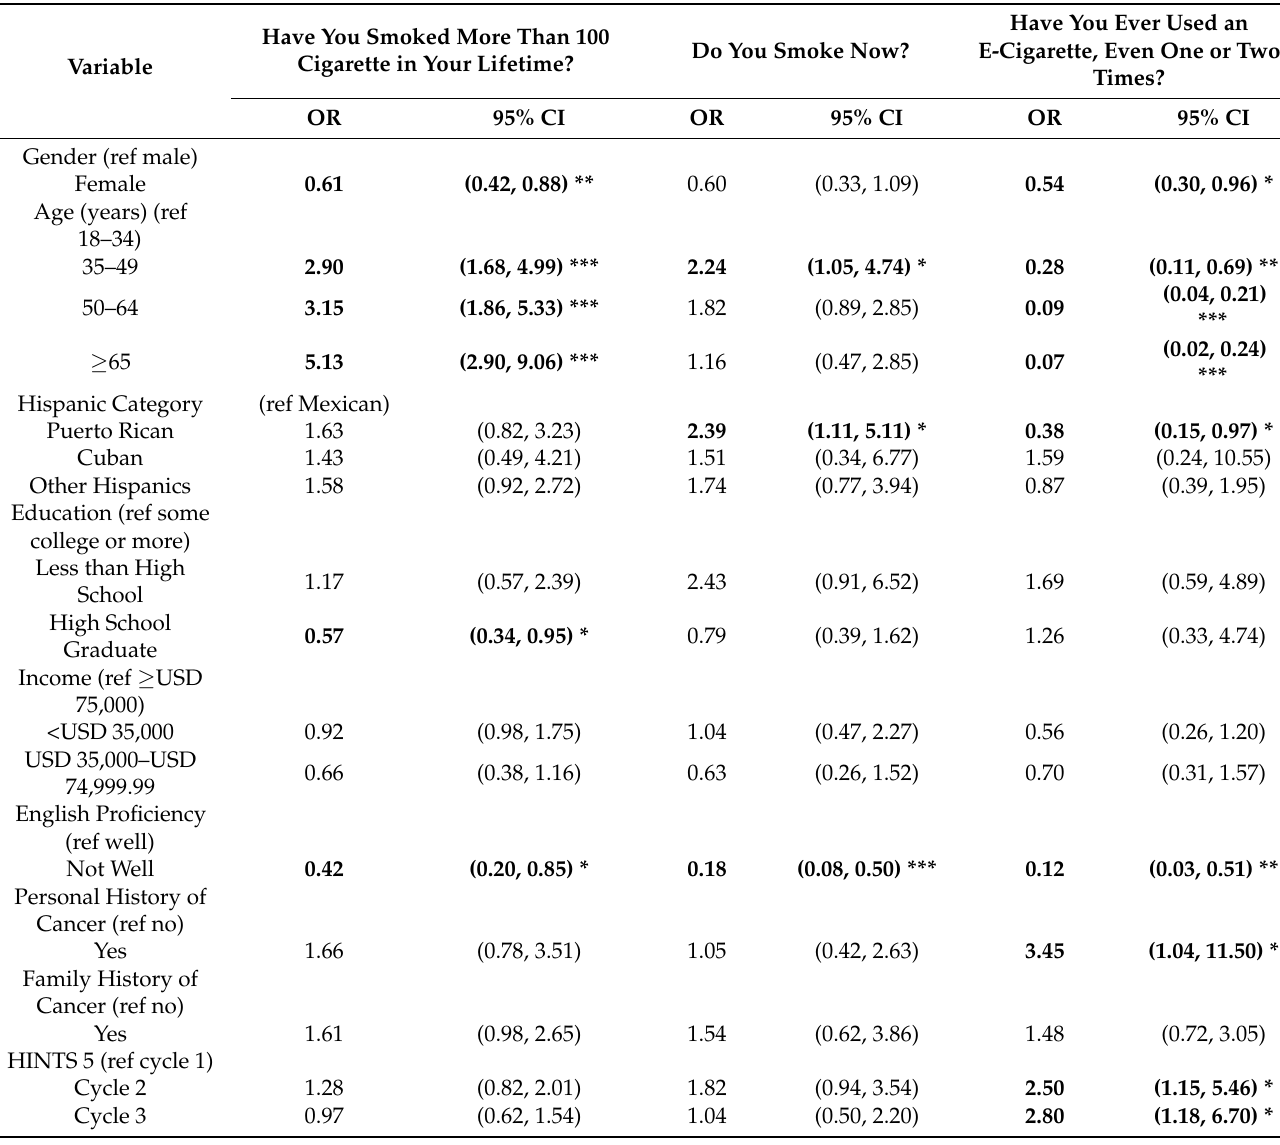
Table 2. Multivariable logistic model results for binary responses for cigarette and e-cigarette use (N = 1618).